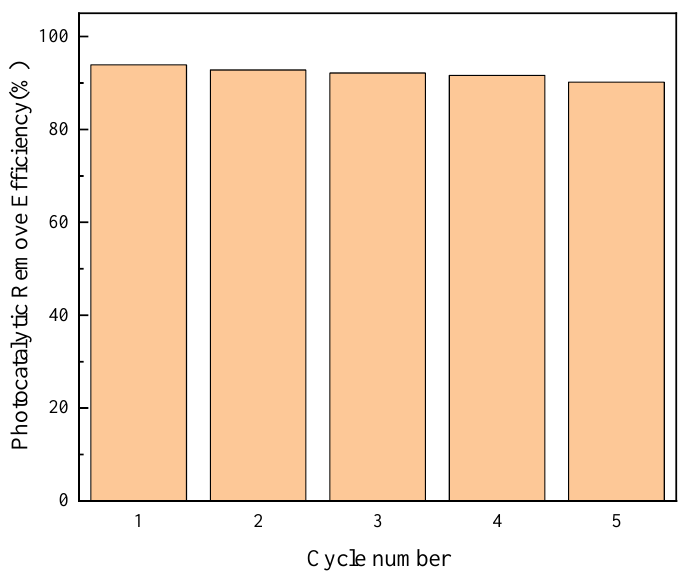
Figure 8. Repeated photodegradation and stability of 1:32 Bi 2 MoO 6 /g-C 3 N 4 for SDZ.